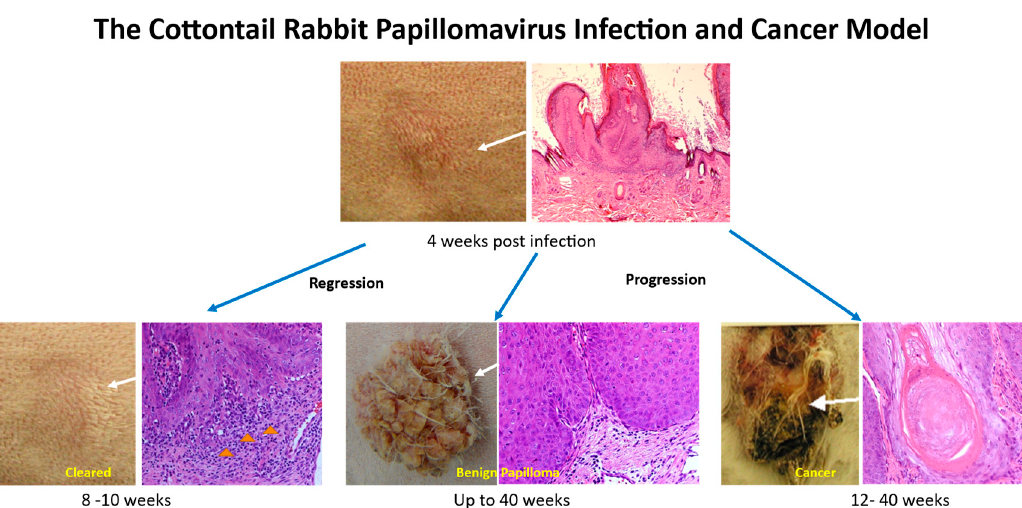
Figure 2. The CRPV rabbit model mimics HPV-associated infections and diseases with predictable disease outcomes at different time frames. Significant immune cell infiltrates (yellow arrows) were found in the tumors undergoing regression.